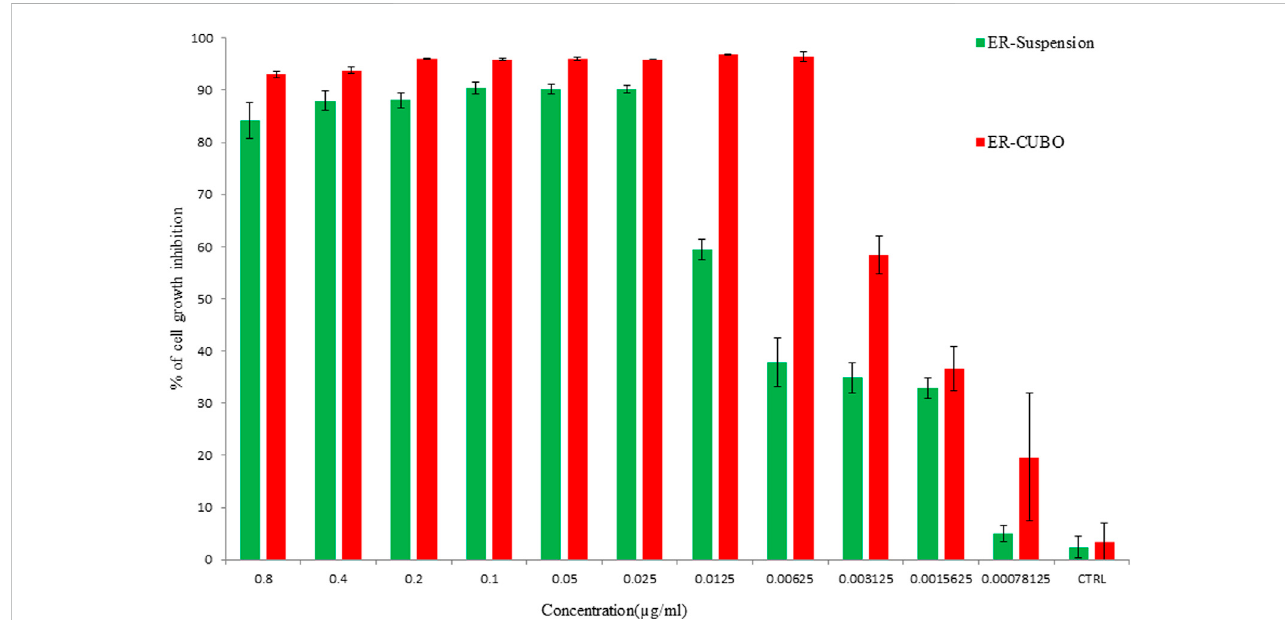
FIGURE 7 Cell viability was determined by using MTT assay. Cells were treated with varying concentrations of the ER and ER-CUB, EAC cancer cells for 24 h. Data represented as mean ± SE at the level of signi fi cance p ≤